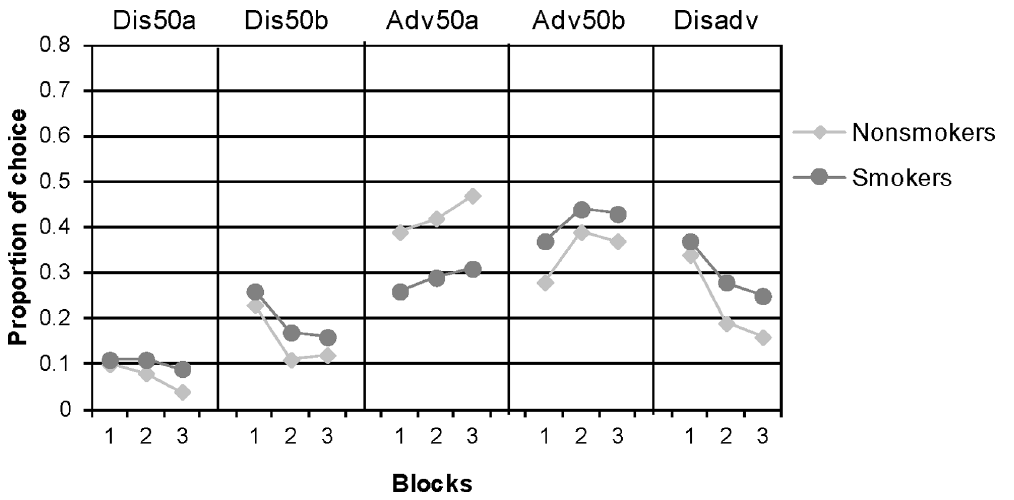
Figure 4. Smokers’ and nonsmokers’ choices as a function of time, by blocks of 20 trials, in the modified EGT (average proportions). The right column (Disadv) shows the proportion of choices from the disadvantageous decks (Dis50a + Dis50b).